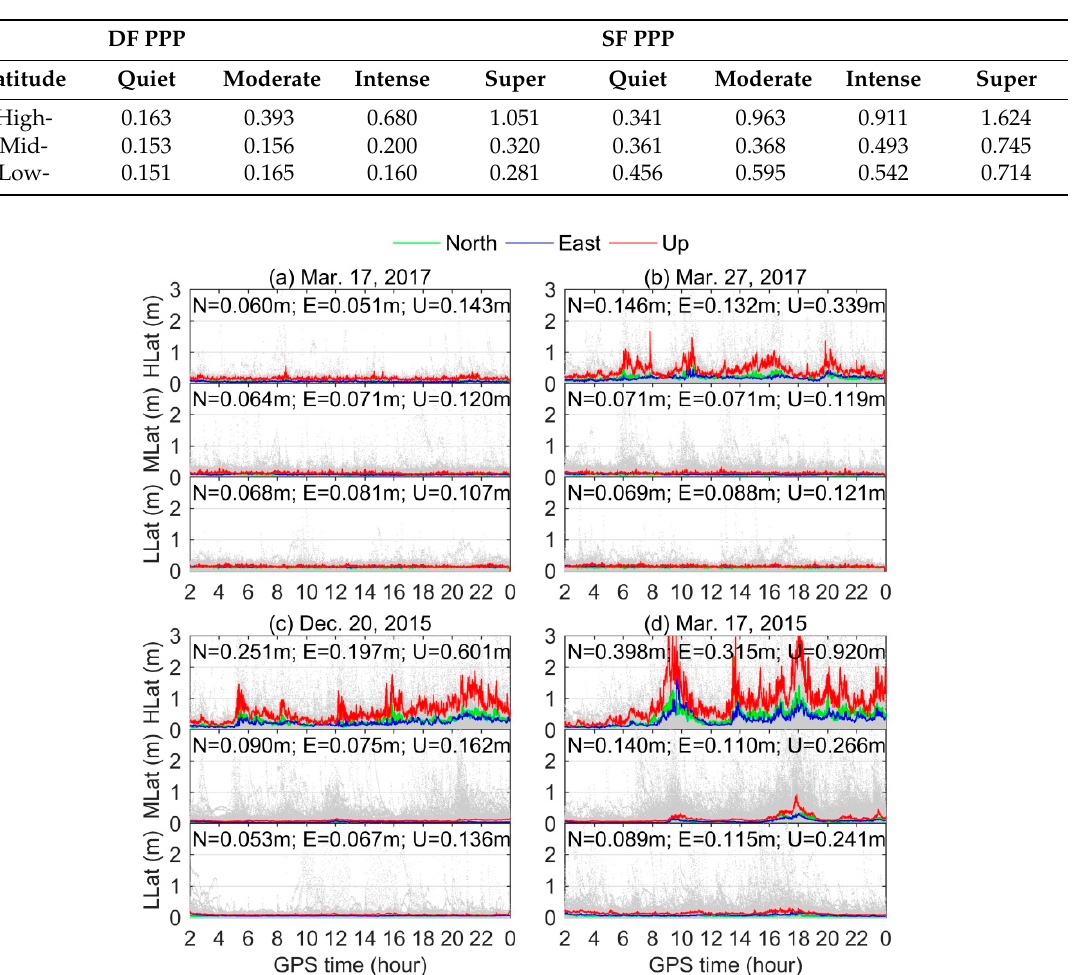
Figure 7. The 90% confidence level of time series of DF PPP results for all stations located at high-, mid-, and low-latitude regions on: ( a ) 17 March 2017 as the quiet day reference; ( b ) 27 March 2017 as the moderate storm; ( c ) 20 December 2015 as the intense storm; and ( d ) 17 March 2015 as the super storm, respectively. The background gray scatters are the absolute values of positioning results for each IGS station. Table 3. The 3D RMS statistics of GPS DF and SF PPP for all stations in high-, mid-, and low-latitudes during the quiet, moderate, intense, and super storms period (Unit: m).